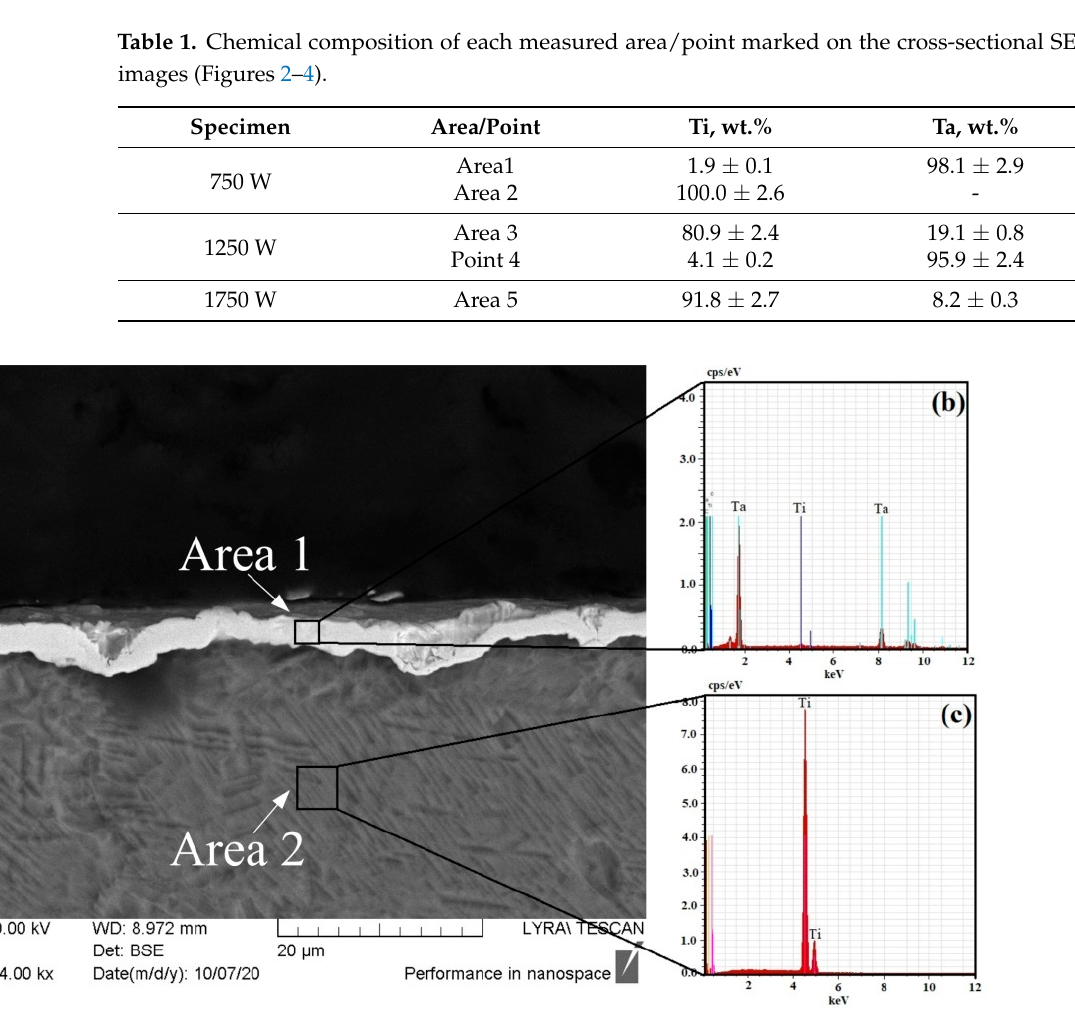
Figure 2. A cross-sectional SEM image of the sample processed with a beam power of 750 W ( a ) and corresponding EDX spectra taken from different regions ( b , c ).